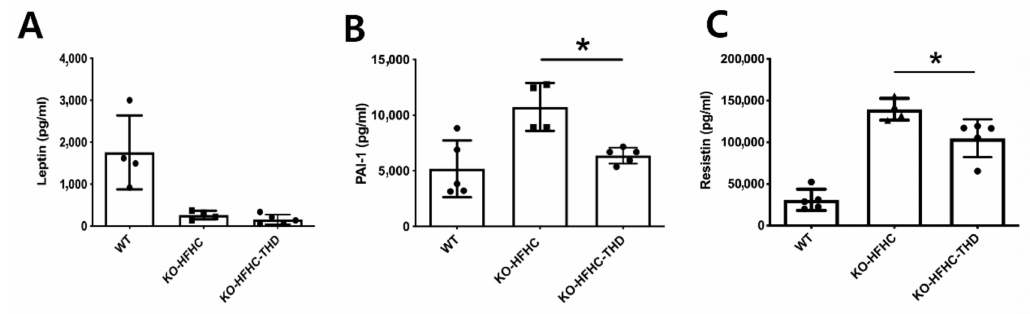
Figure 5. THD decreases serum levels of PAI-1 and resistin. The plasma levels of leptin ( A ), PAI-1 ( B ), and resistin ( C ) were analyzed by immunoassay analysis. WT-HFHC, wild type–high fat high cholesterol; KO-HFHC, ApoE- / - high fat high cholesterol; KO-HFHC-THD, ApoE- / - high fat high cholesterol–tongqiaohuoxue decoction. * p < 0.001 vs. KO-HFHC.